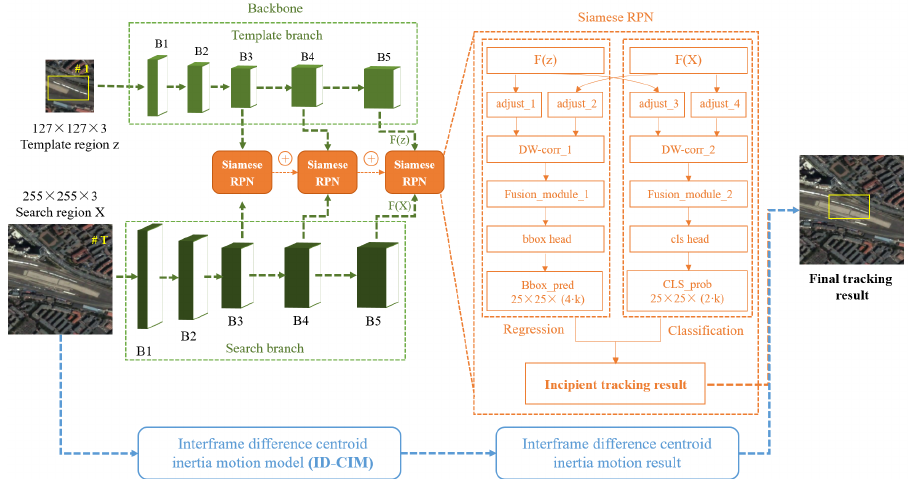
Figure 2. The overall structure of interframe difference deep Siamese network (ID-DSN). It consists of the DSN module (shown as green and orange blocks) and the interframe difference centroid inertia motion (ID-CIM) module (shown as blue blocks). These two modules mutually reinforce the final tracking result. The DSN inherently includes a template branch and a search branch, and they share